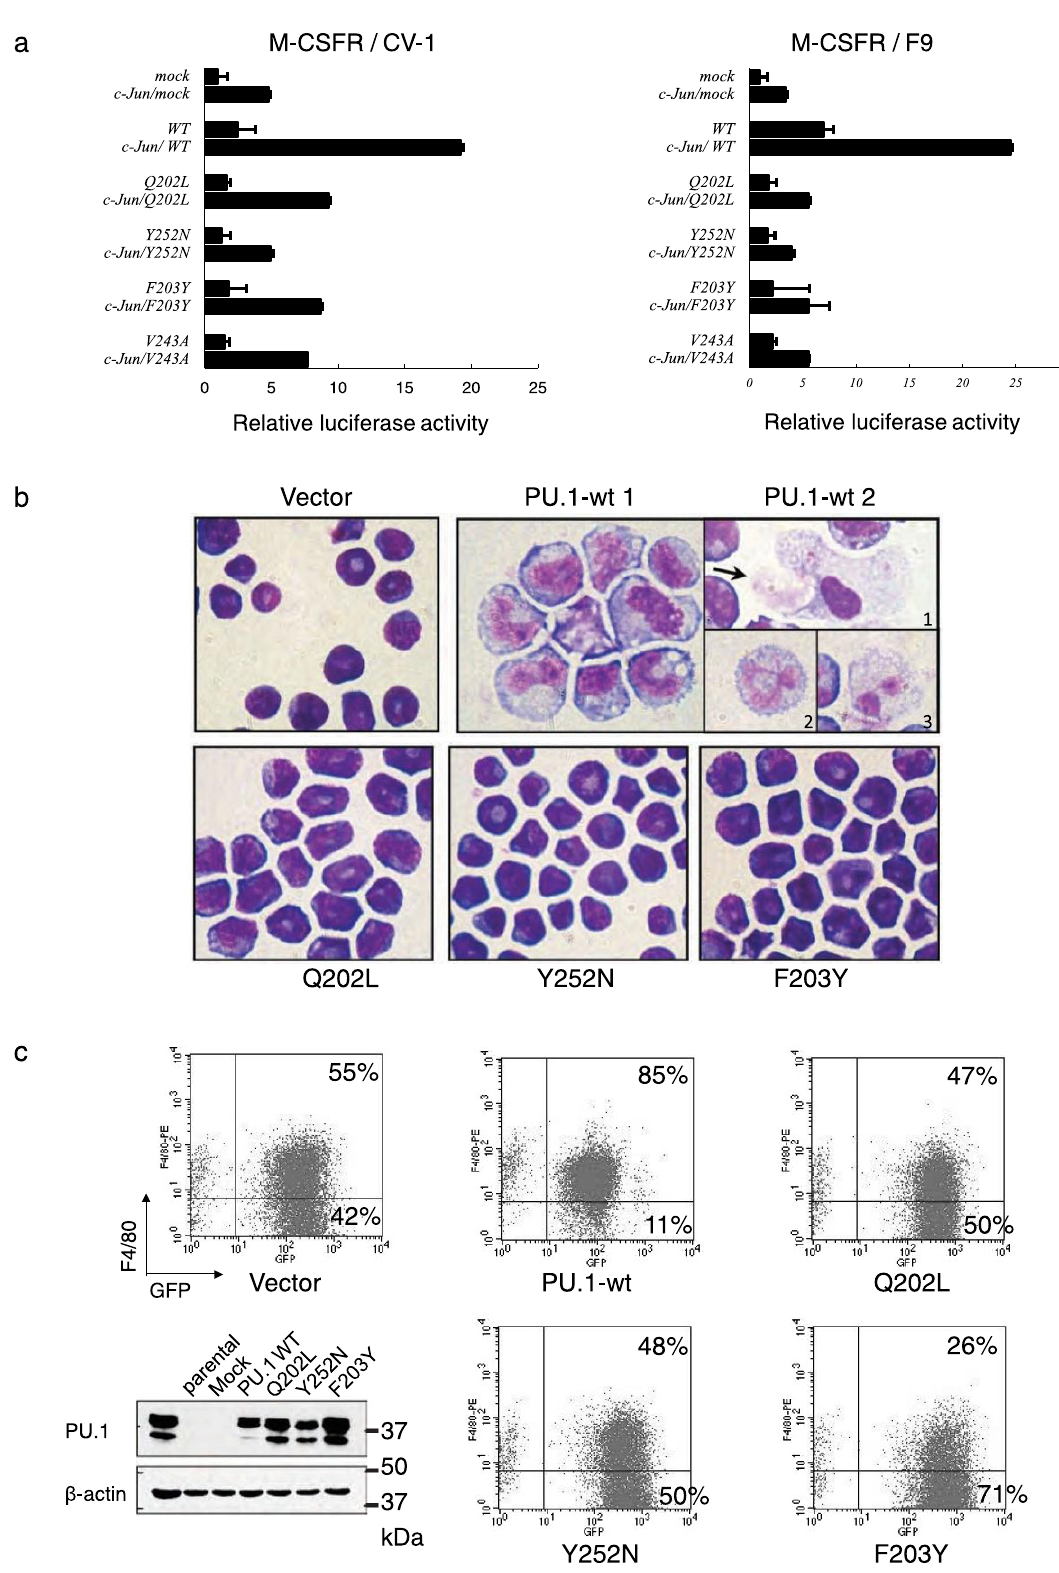
Expression of a mutant PU.1 fused to c-Jun partially rescues the differentiation block . To demonstrate that the reduced transcriptional activity of PU.1 mutants was caused speci fi cally by the failure to interact with and recruit c-Jun to target promoters, we performed rescue experiments using mutant PU.1 fused to c-Jun via a fl exible poly - linker (Fig. 4a). Newborn liver cells